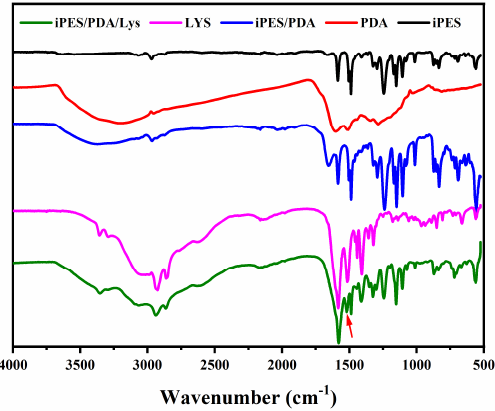
Figure 3. ATR ‐ FTIR spectra of iPES, PDA, Lys, iPES/PDA, and the iPES/PDA/Lys composite mem ‐ Figure 3. ATR-FTIR spectra of iPES, PDA, Lys, iPES/PDA, and the iPES/PDA/Lys composite branes.